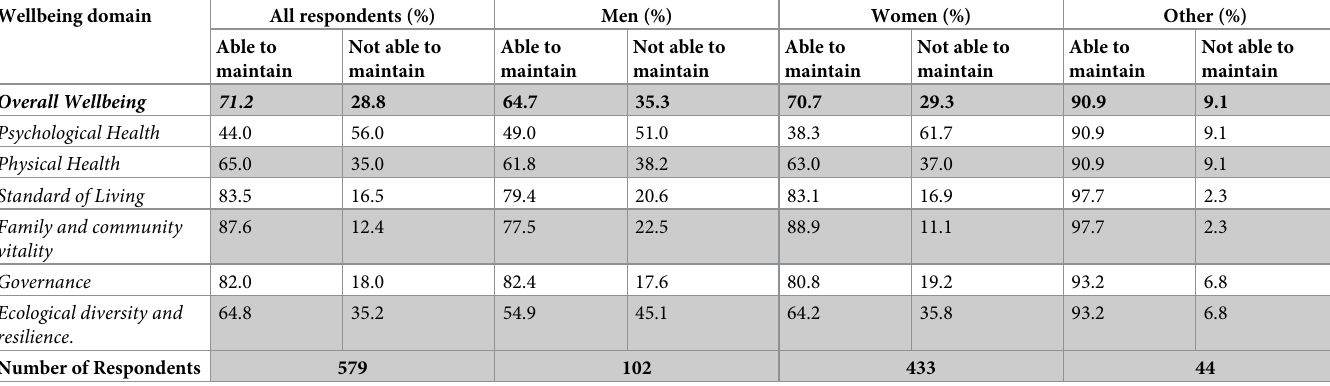
Table 1. Percentage distribution of respondents by gender and who were able/not able to maintain wellbeing. South Australia. 2020. Wellbeing